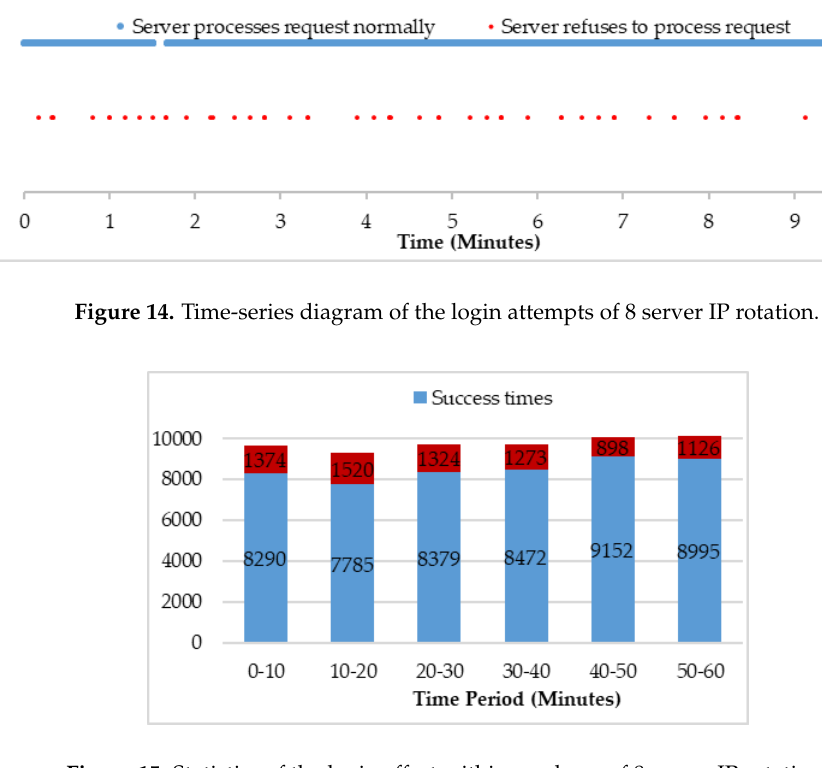
Figure 15. Statistics of the login effect within one hour of 8 server IP rotation.